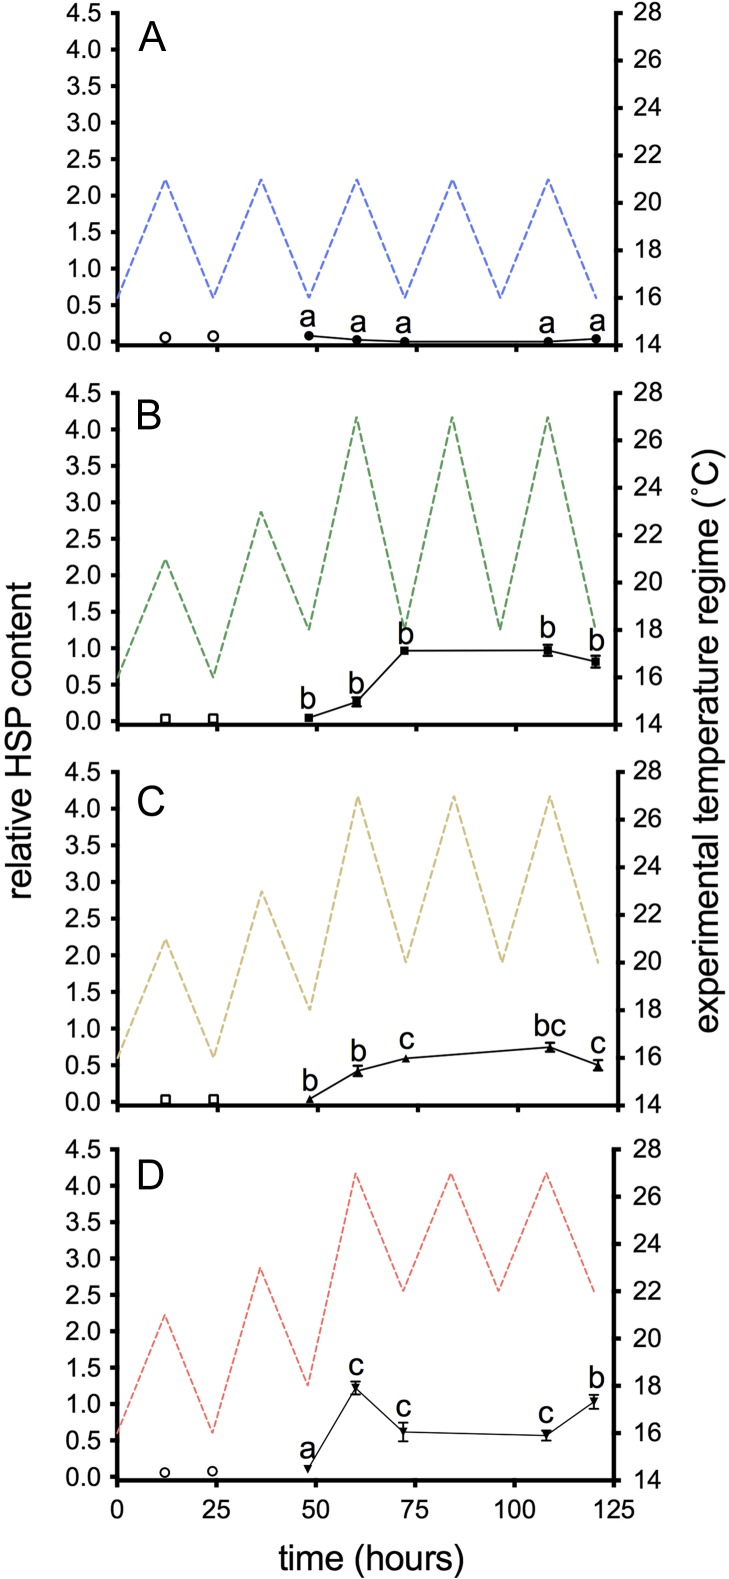
RBC HSP70 in juvenile salmon exposed to diel cycles: (A) 16–21°C only; or multi-day thermal stress (closed symbols; 60–120 h) of (B) 18–27°C; (C) 20–27°C; (D) 22–27°C. Data are presented as mean ± SEM (n = 5–9). Pre-thermal stress sampling (open symbols; t = 12 and 24 h) assessed the effect of ‘trial’ and was not included in the analysis. Letters indicate significant differences among treatments (P < 0.05) within sampling time points.